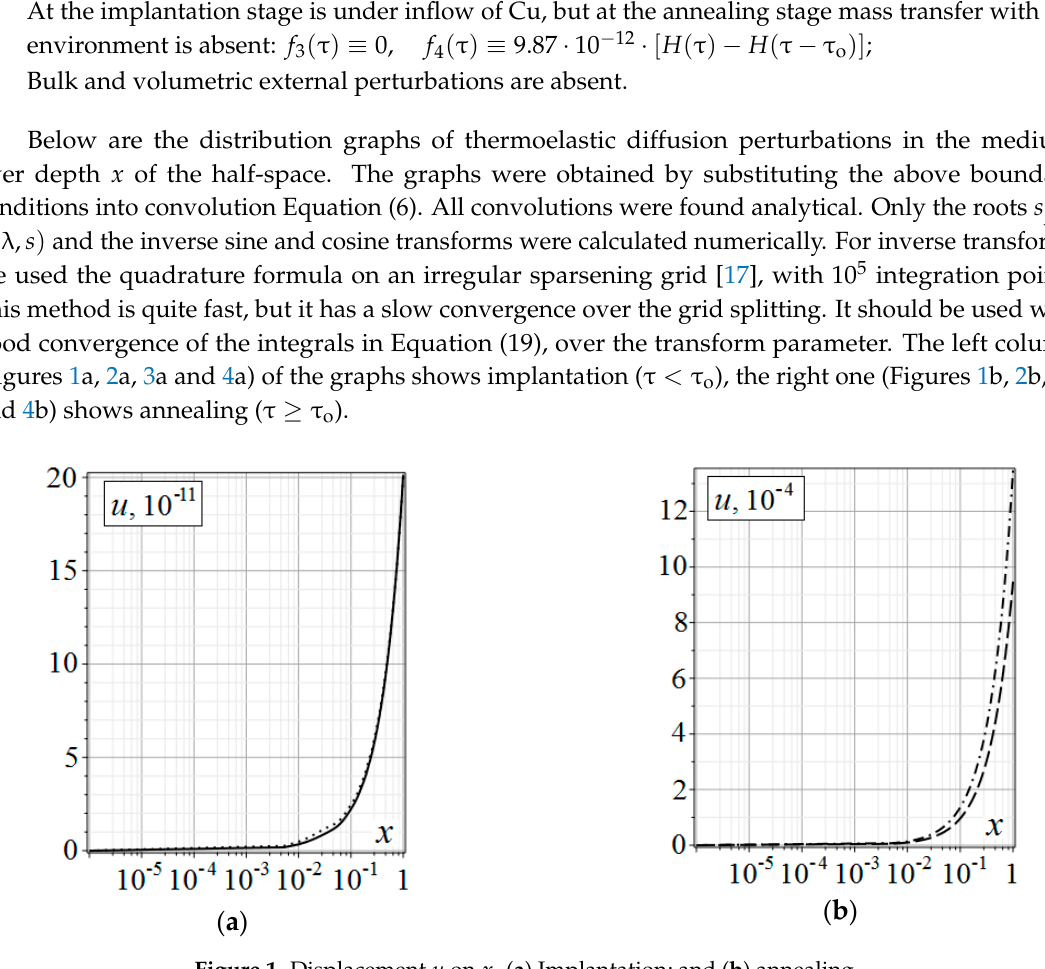
Figure 1. Displacement u on x . ( a ) Implantation; and ( b ) annealing. Math. Comput. Appl. 2019 , 24 , x FOR PEER REVIEW